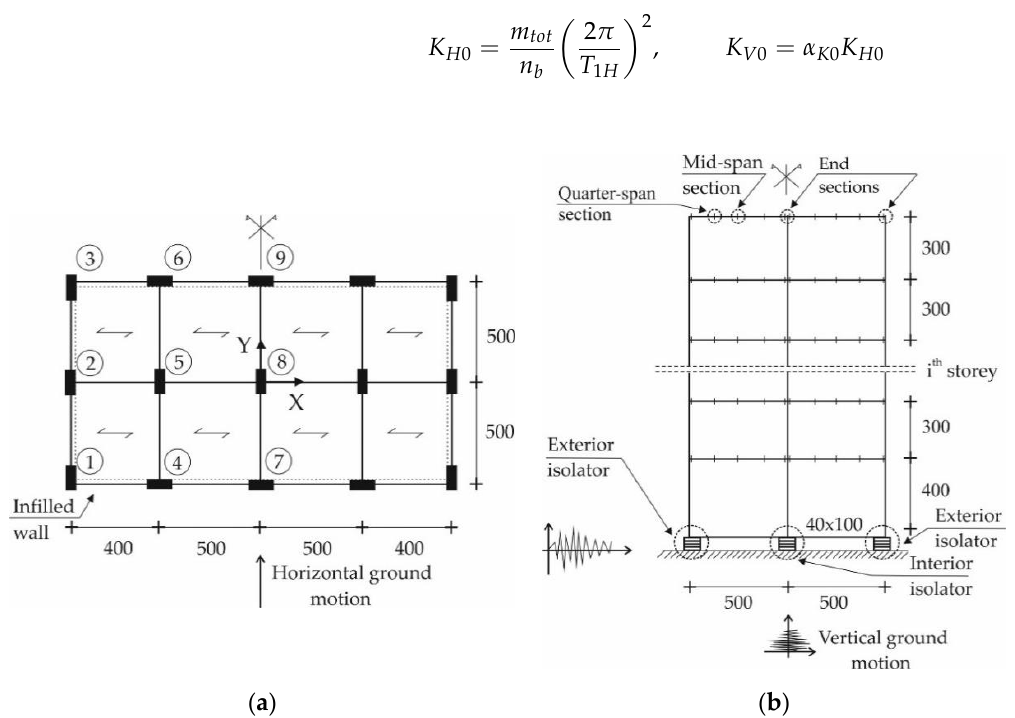
Figure 2. Three-, seven- and ten-storey structures—( a ) plan; ( b ) elevation (dimensions in cm).